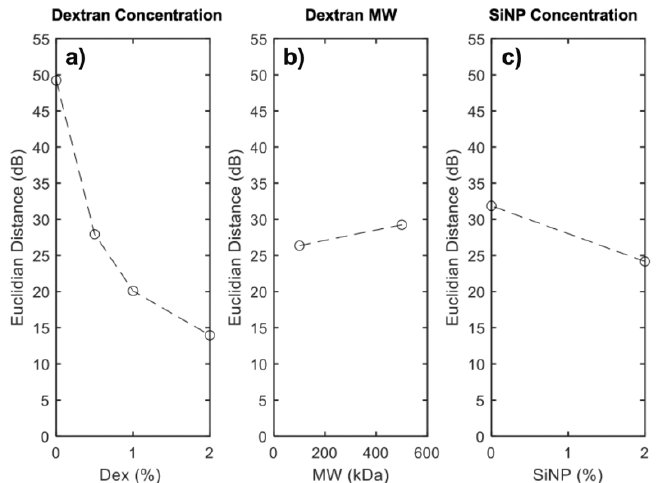
Figure 5. Euclidean distance from the Han plots for ( a ) dextran concentration, ( b ) dextran molecular weight, and ( c ) silica nanoparticle concentration.